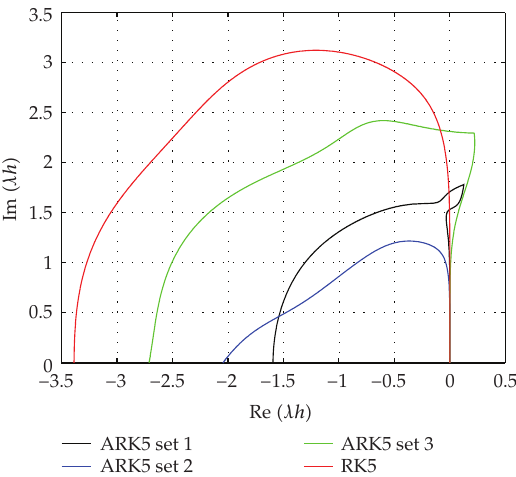
Figure 18: Stability region of ARK5 sets of Table 4 and RK5 set of Table